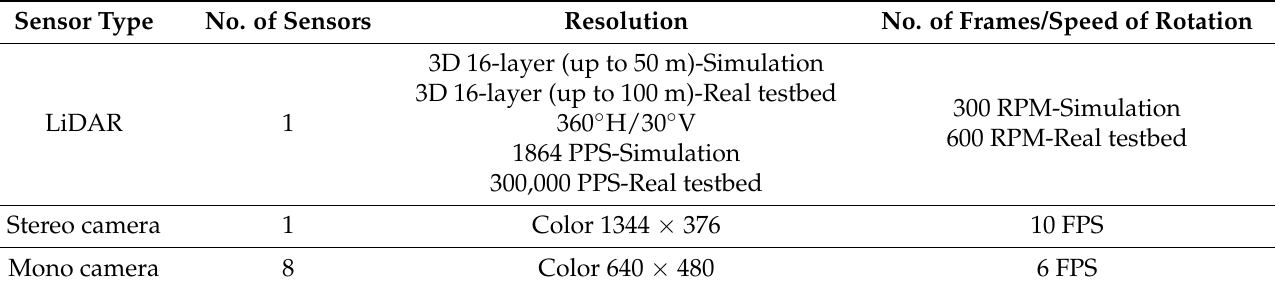
Table 1. Properties of sensors for both simulation and real